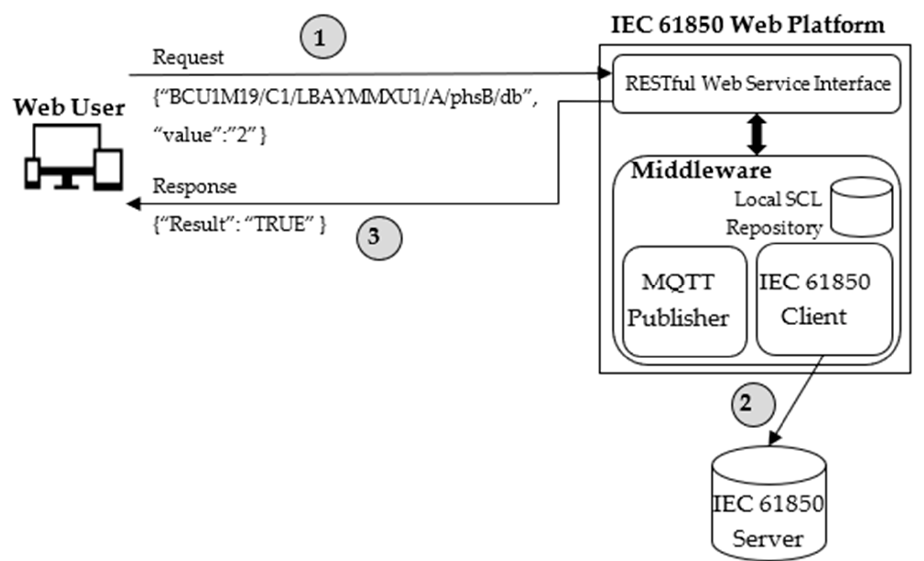
Figure 10. Example of updating of a value belonging to a Basic Data Attribute.